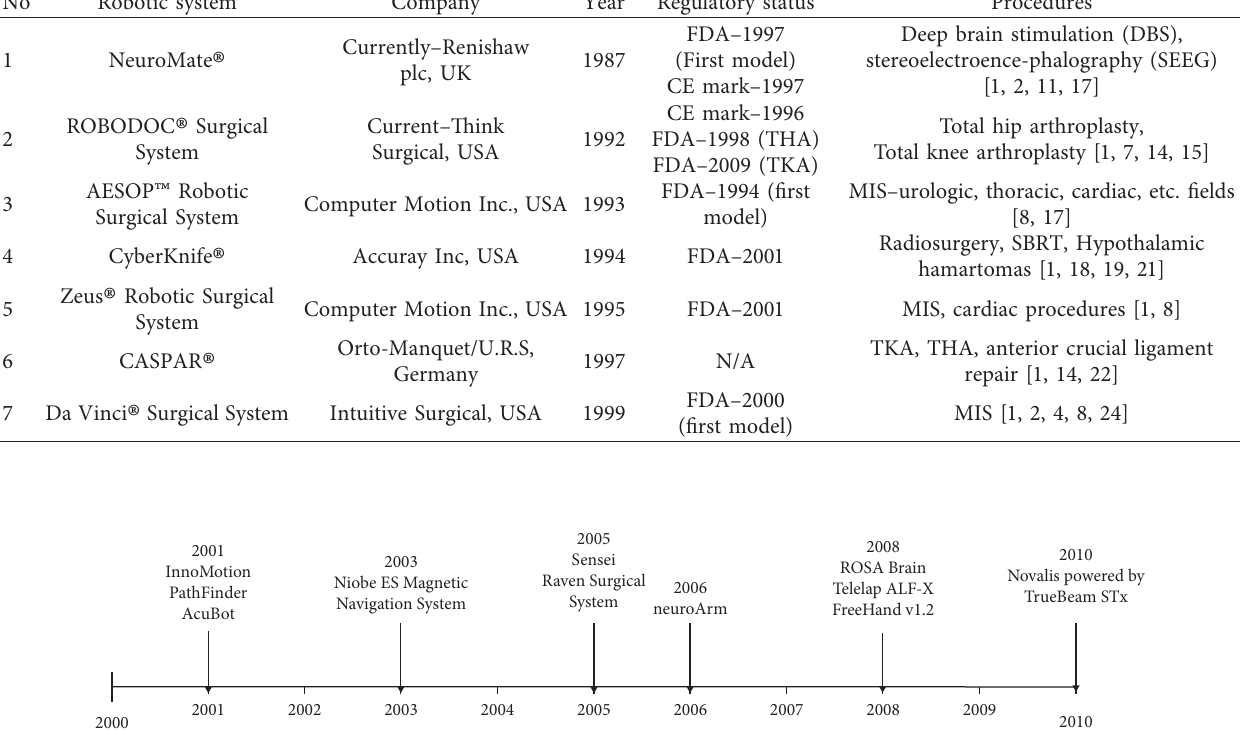
Figure 2: Decade II–timeline of robotic systems that signify the progress of the development curve of Robots in medical